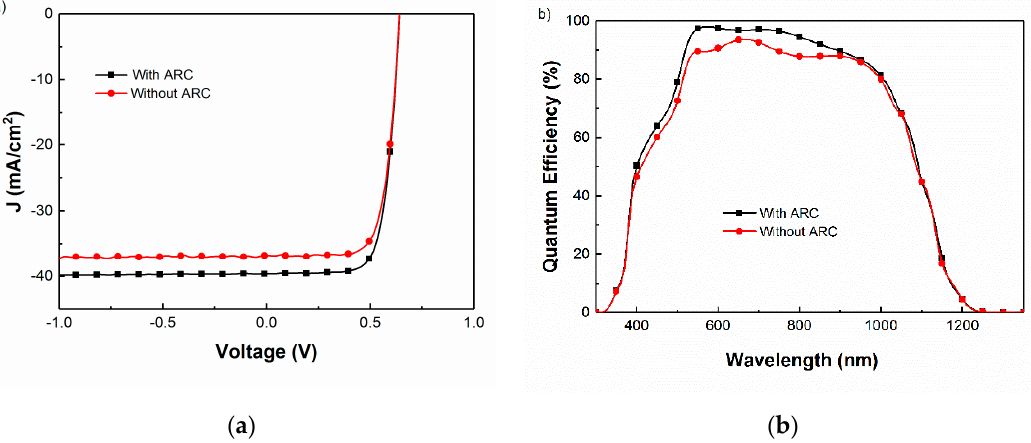
Figure 5. ( a ) Real-time variation of the reflectance during the course of deposition of the AR layer ( t = 3 to 12 min). ( b ) Real-time variation of the reflectance of the CIGS structure with increased thickness of the AR layer.